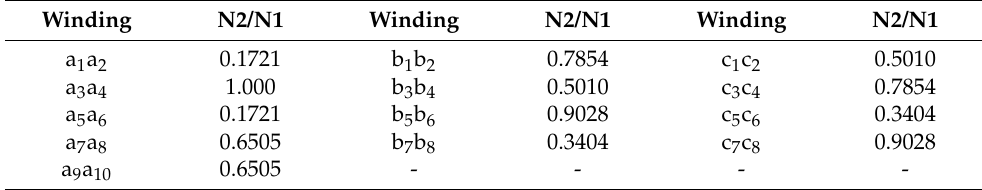
Table 3. Turn ratios of the secondary